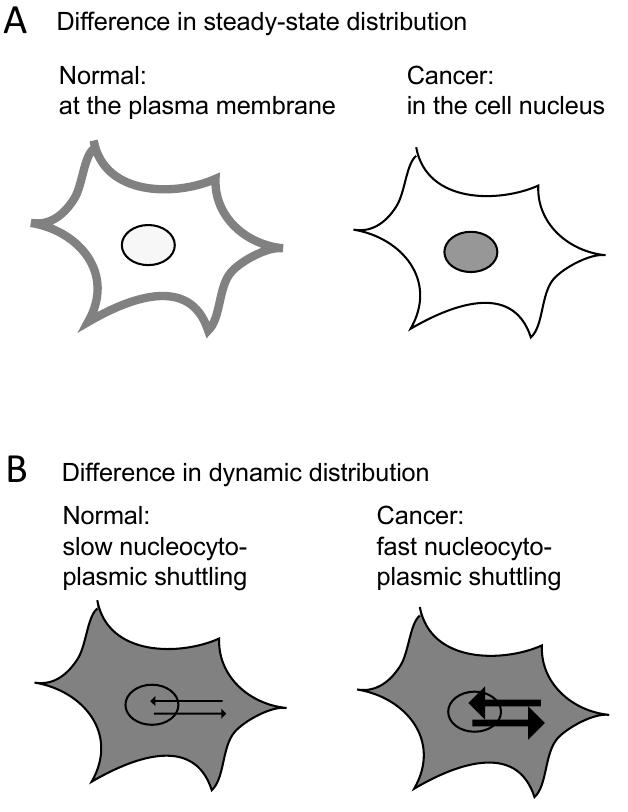
Figure 3. Schematic of intracellular compartment shifts. Scenario ( A ) Difference in steady-state distribution, e.g., beta-catenin. Scenario ( B ) Differences in dynamic distribution, e.g.,